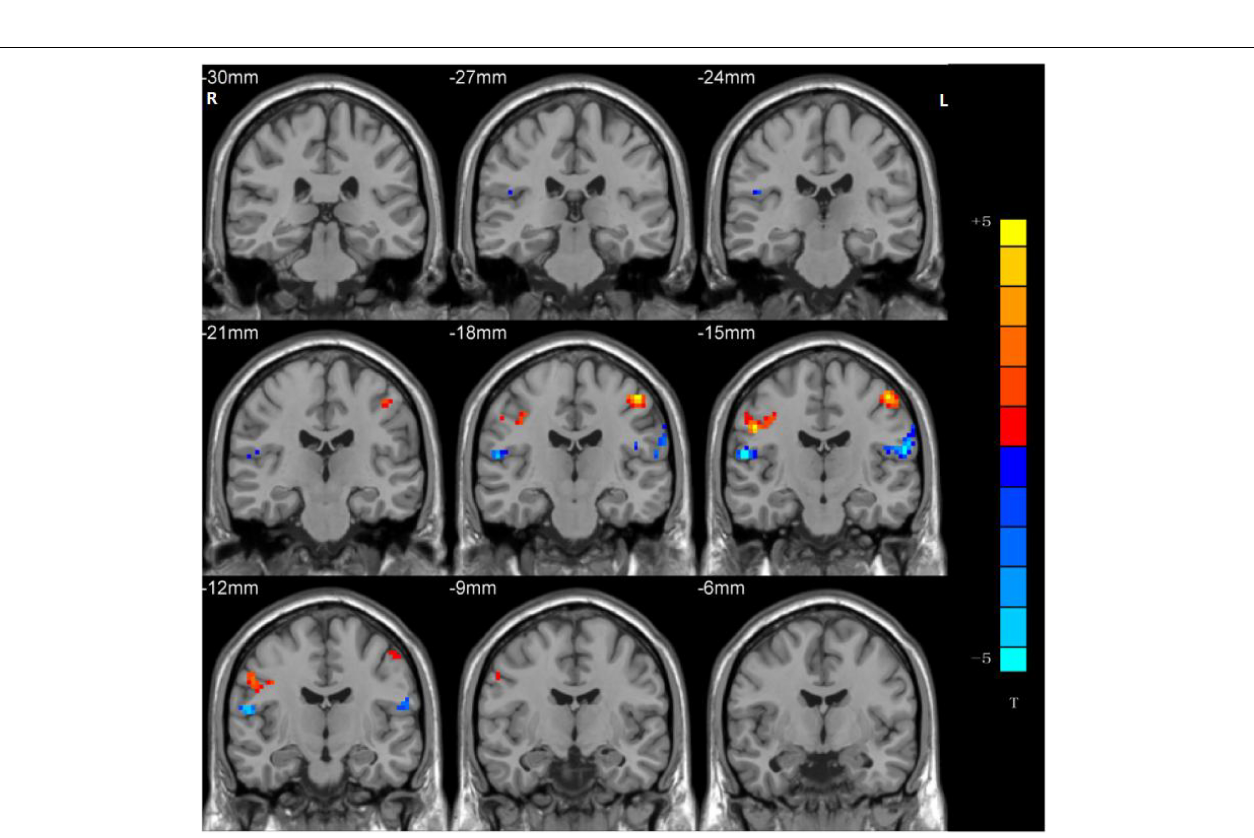
FIGURE 2 | Statistical maps showing NH differences in the bilateral postcentral gyrus, the bilateral Rolandic operculum and the right STG between the rTLE group and control group. (Blue indicates lower NH and the color bar indicates the t -values from the two-sample t -test).